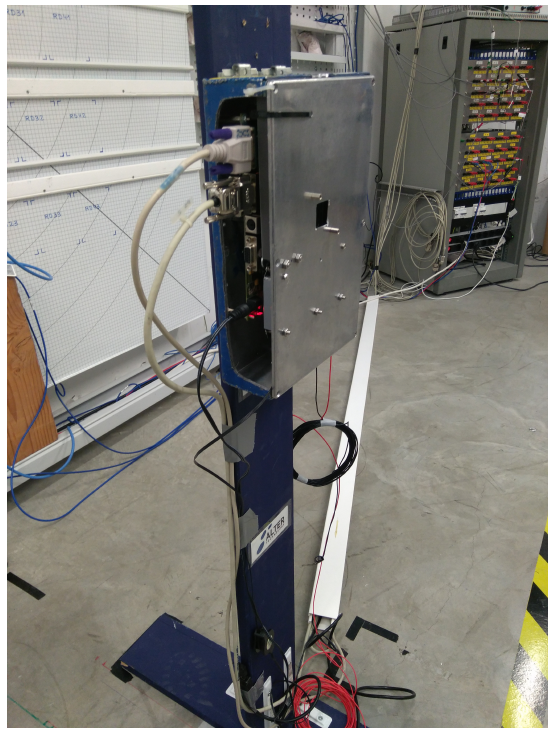
Figure 5. Filter Box with the PCB (and DUT) inside and the connections to the different ports and power